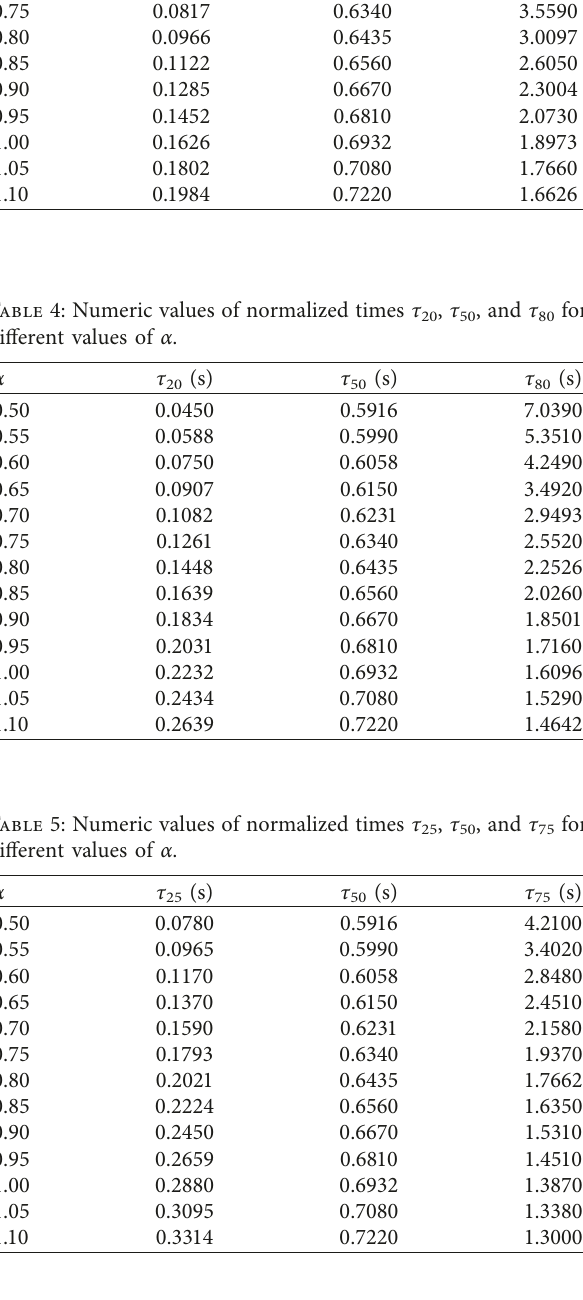
30 , τ 50 , and τ 70 for